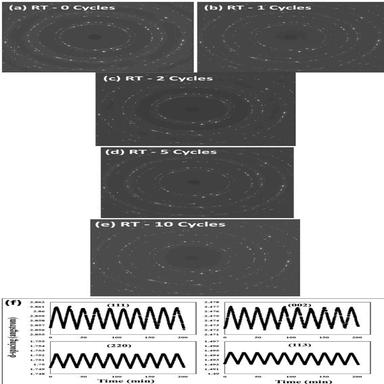
Full Debye-Scherrer diffraction rings of pure Pb at room temperature taken (a) before the first cycle and (b–e) after cycles 1, 2, 5, and 10. (f) Fitted peak position vs. time for the (111), (002), (220), and (113) reflections from the pure Pb foil over 10 thermal cycles.